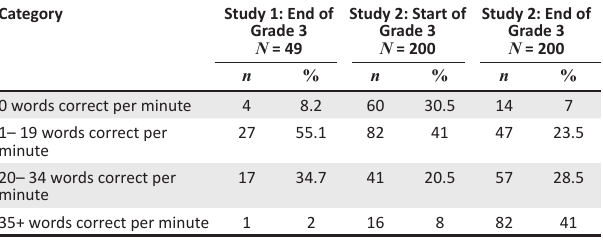
TABLE A1: Number and proportion of participants per oral reading fluency category in study 1 and study 2.